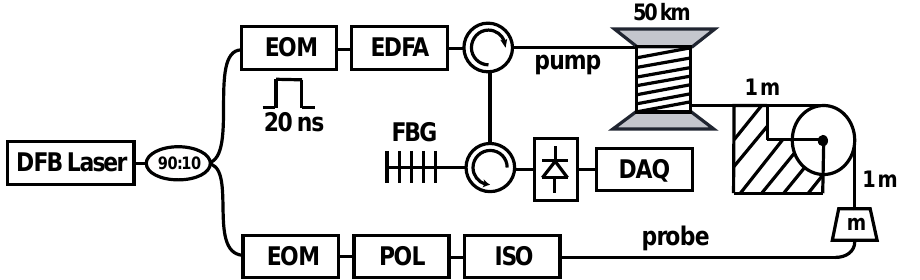
Figure 1. Experimental setup of a standard Brillouin optical time-domain analysis (BOTDA) sen- sor over a 50 km-long sensing fiber. A short and sharp strain variation is applied along a 2-m-long section near the far fiber end.